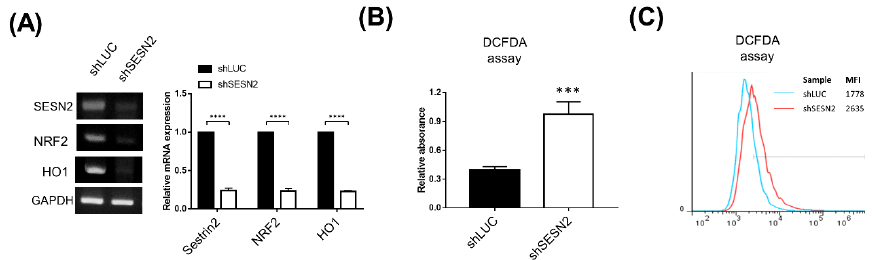
Figure 3. Sestrin2 knockdown leads to reactive oxygen species (ROS) overproduction by inhibiting the oxidative stress response. ( A ) Expression of NRF2 and HO-1 in control and shSESN2 A549 cells measuredbyRT-PCR.A549cellsweretransducedwithlentiviralpLSLPw-shLUCandshSESN2plasmids. ( B ) 2 (cid:48) ,7 (cid:48) -Dichlorodihydrofluorescein diacetate (DCFDA) cellular ROS assay. A549 cells were stained with DCFDA and washed. The emitted fluorescence was measured using a fluorescence microplate reader ( B ) and flow cytometer ( C ). MFI: mean fluorescence intensity (*** p < 0.005; **** p <